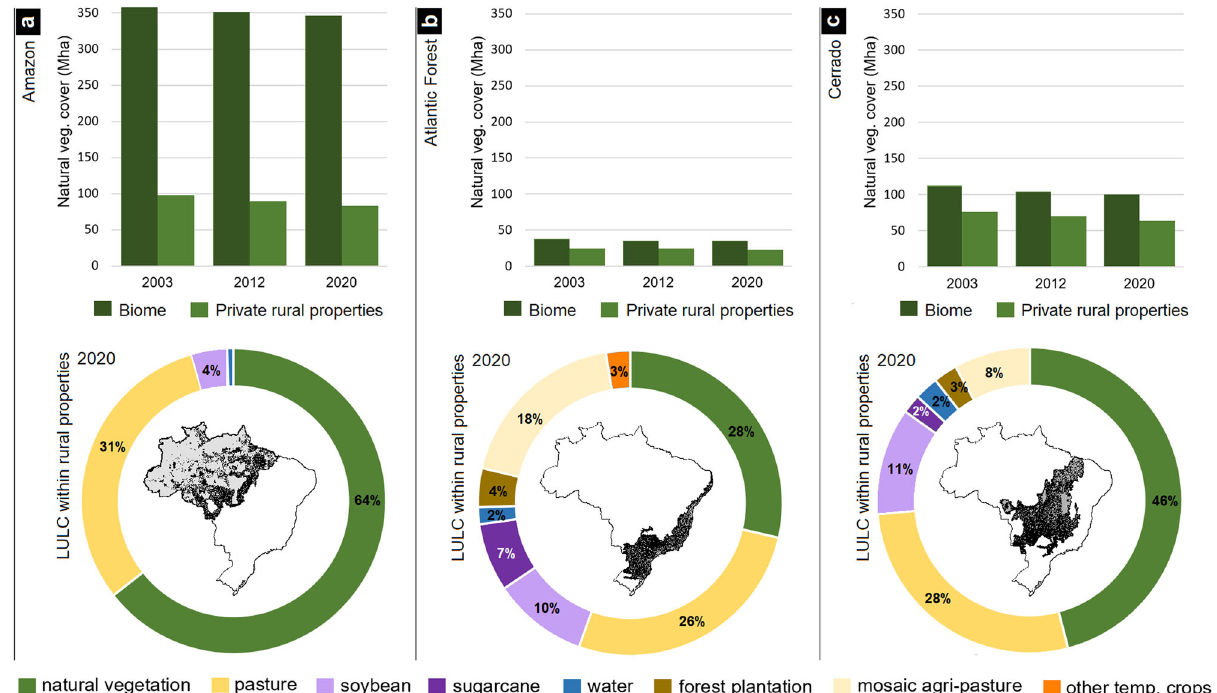
Fig. 1 Natural vegetation cover through time, and land use and land cover within private rural properties in 2020. a Amazon biome; b Atlantic Forest biome; c Cerrado biome. In the upper panels the bar charts indicate the total natural vegetation cover at the biome level (darker shade) and the relative area within rural private properties (lighter shade); In the lower panels the doughnut charts show the proportion of LULC found in rural private properties in the three biomes analyzed (colors are for land use/cover shown in the legend below the